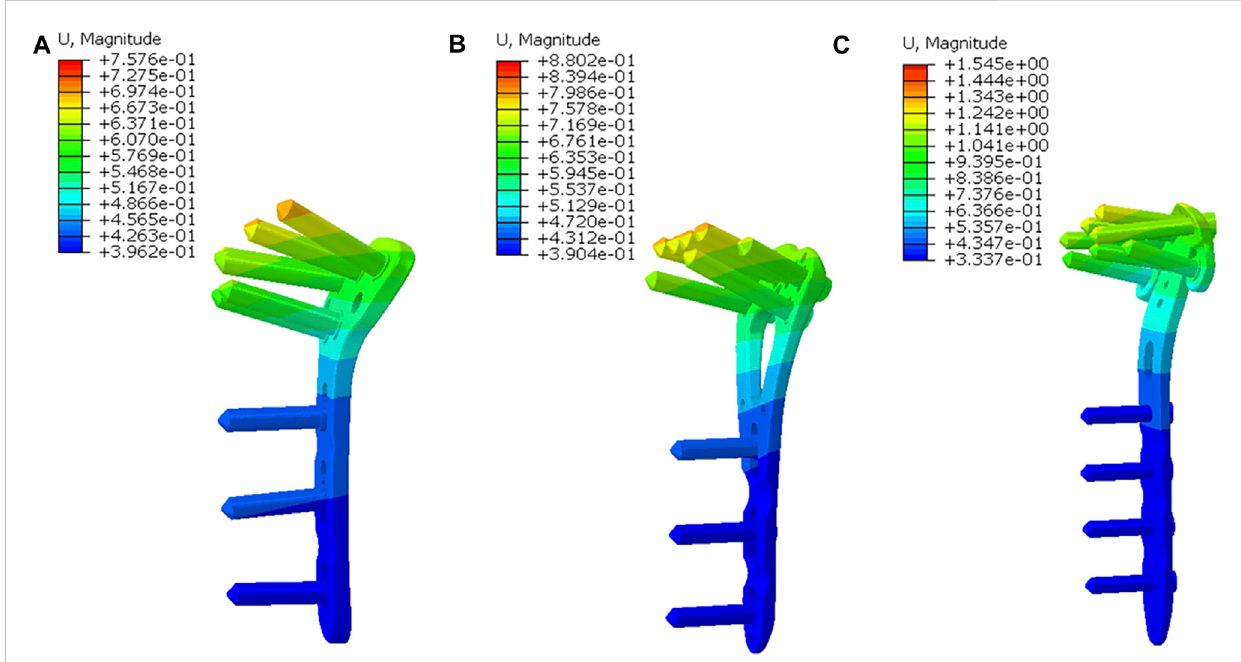
The strain nephogram of implants and the most obvious strain distribution was observed at the junction of plate head and body. (A) The strain nephogram intheTplate; (B) The nephogram intheV plateand theprincipalstrain wassimilar tothat intheTplate. (C) Thenephograminthe π plate and the principal strain was higher than those in the other two